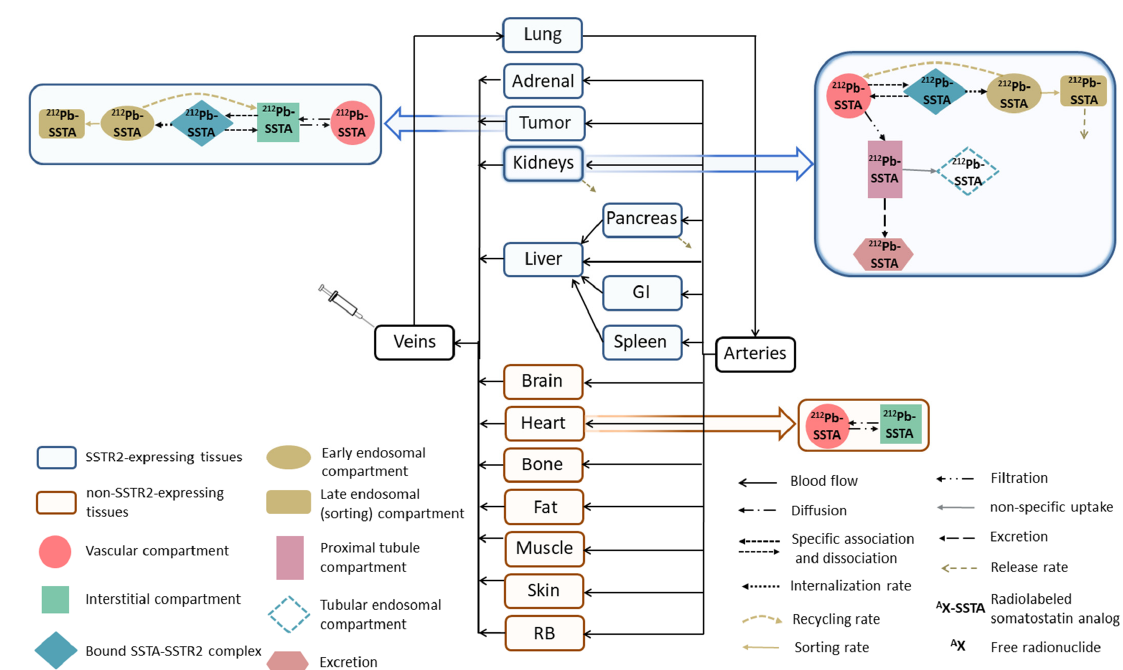
Figure 1. Scheme of the 212 Pb-SSTA-PBPK model for mice. The model describes the PK of [ 212 Pb]Pb-SSTA and the fate of its decay products in tissues. [ 212 Pb]Pb-SSTA are distributed in the circulation to the vascular compartments of SSTR2- expressing and non-SSTR2-expressing tissues. After the diffusion of [ 212 Pb]Pb-SSTA to the interstitial compartments, [ 212 Pb]Pb-SSTA undergo specific binding followed by internalization to early endosomes where [ 212 Pb]Pb-SSTA are either recycled back to the interstitial compartments or directed to the sorting compartments for degradation. Non-SSTR2- expressing tissues include only vascular and interstitial compartments. Each compartment in the 212 Pb-SSTA-PBPK model represents the in vivo alpha particle generator model.